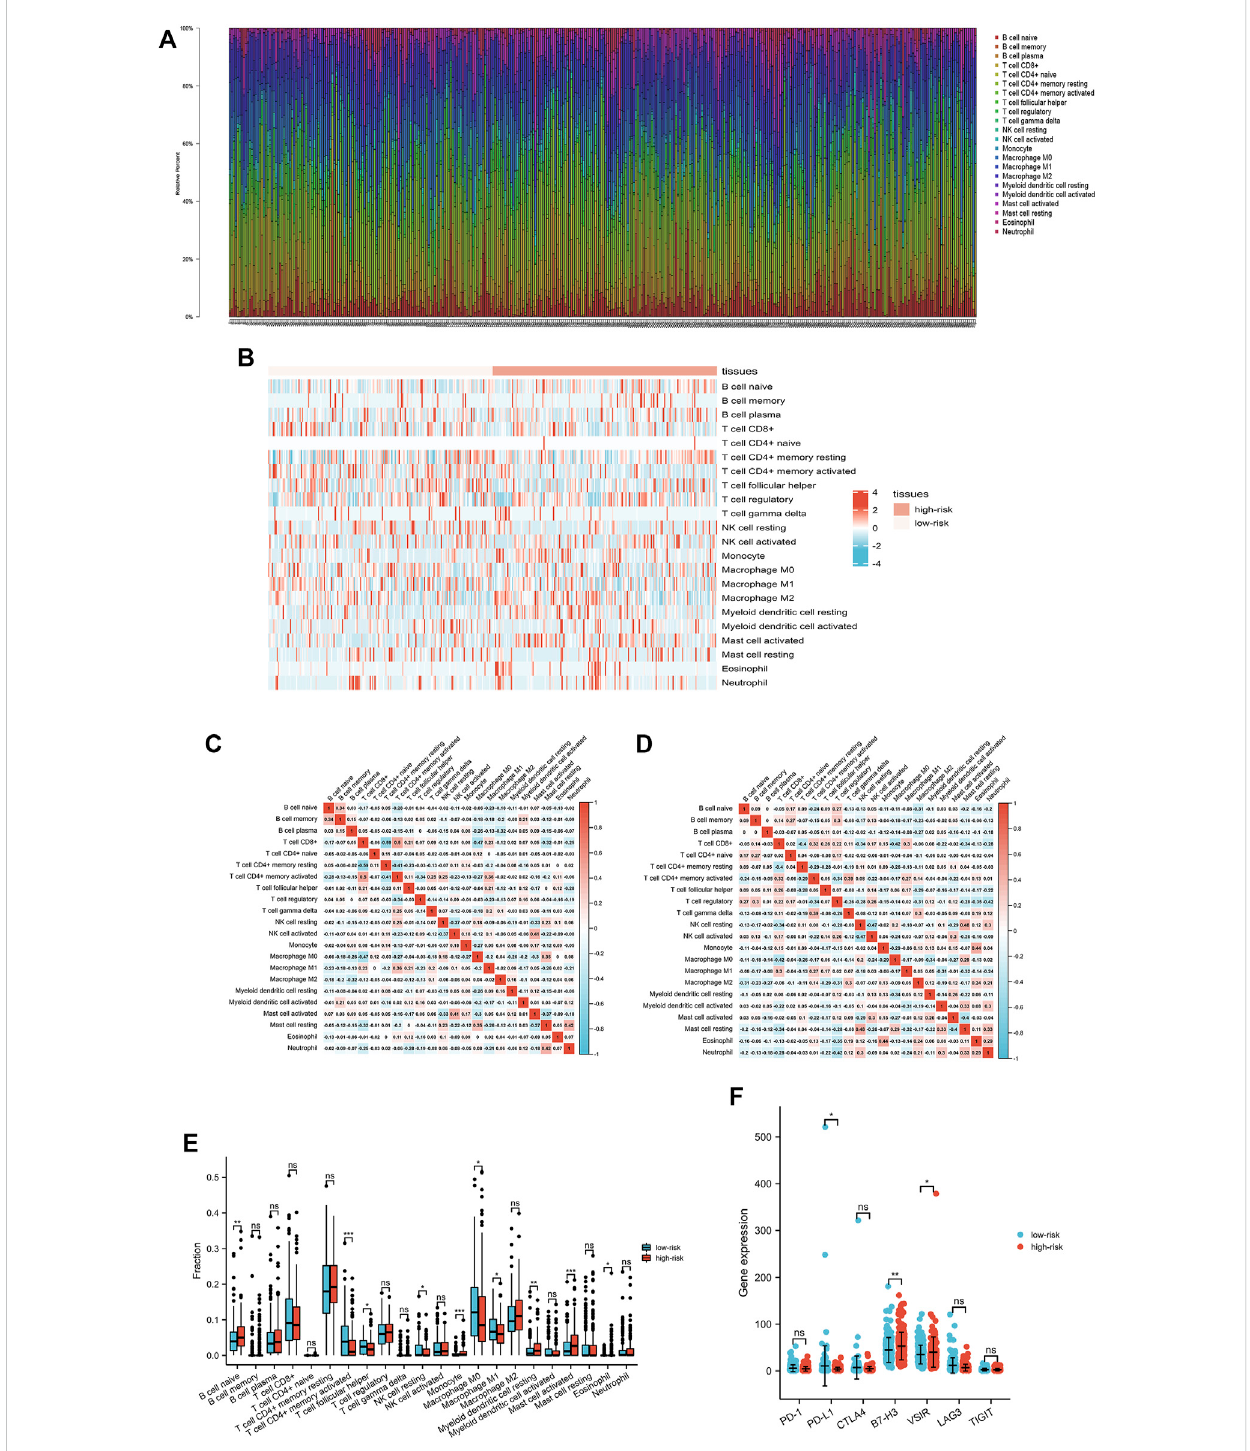
FIGURE 6 InteractionsbetweentheICD-relatedlncRNAsignatureandimmuneregulationinpatientswithgastriccancer. (A) Degreeofimmunecellin fi ltration (B) Heatmap of tumor-in fi ltrating cells in low- and high-risk patients. (C, D) Correlation matrix of immune cells in gastric cancer. (E) Comparisons of immunecellsbetweenlow-andhigh-riskgroups. (F) Comparisonofmultipleimmunecheckpointsbetweenlow-riskandhigh-riskgroups,includingPD- 1, PD-L1, CTLA4, B7-H3, VSIR, LAG3, and